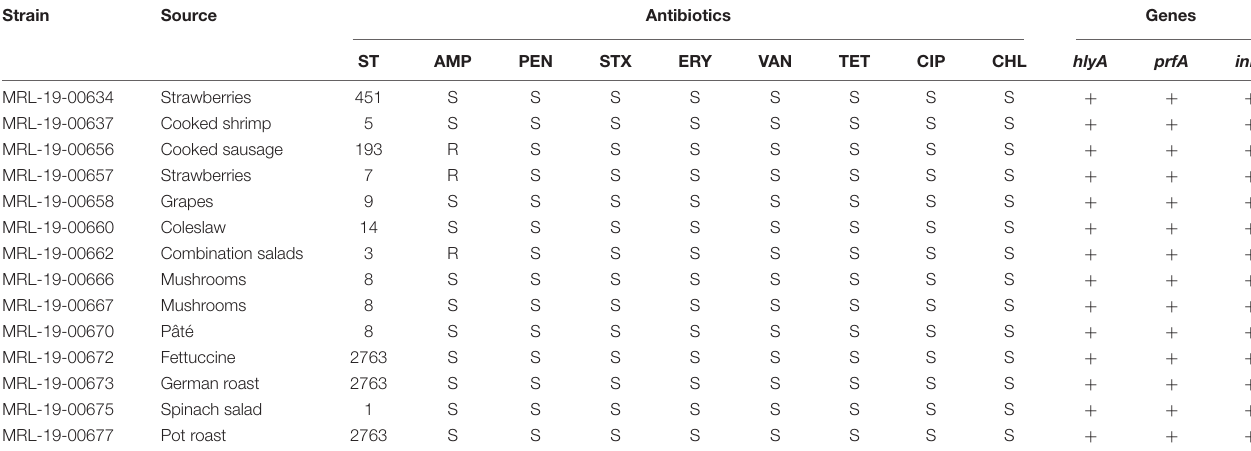
TABLE 3 | Detection of putative virulence genes and antibiotic resistance profile of L. monocytogenes strains. Strain Source Antibiotics Genes